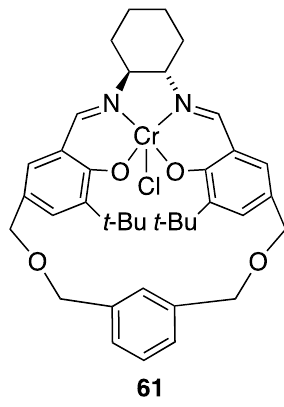
Figure 24. Macrocyclic Cr–salen complex 61 .